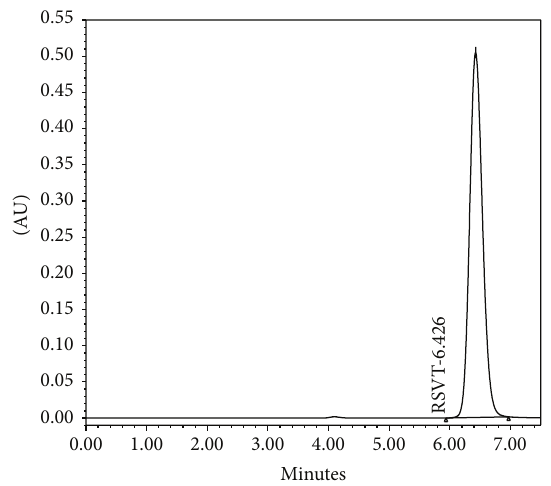
Figure 1: Representative HPLC chromatograms of RVT standard (40 𝜇 g/mL) in methanol :water. Mobile phase, methanol :water (51:49, v/v); flow rate, 0.9 mL/min; PDA detection wavelength, 306 nm; column temperature, 25 ∘ C; injection volume, 20 𝜇